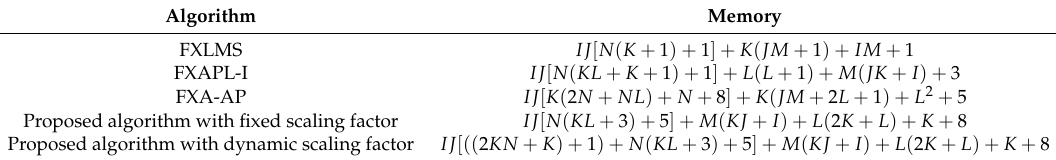
Table 6. Memory requirements for the FXLMS, FXAPL-I, FXA-AP and the proposed algorithm for multichannel ANC